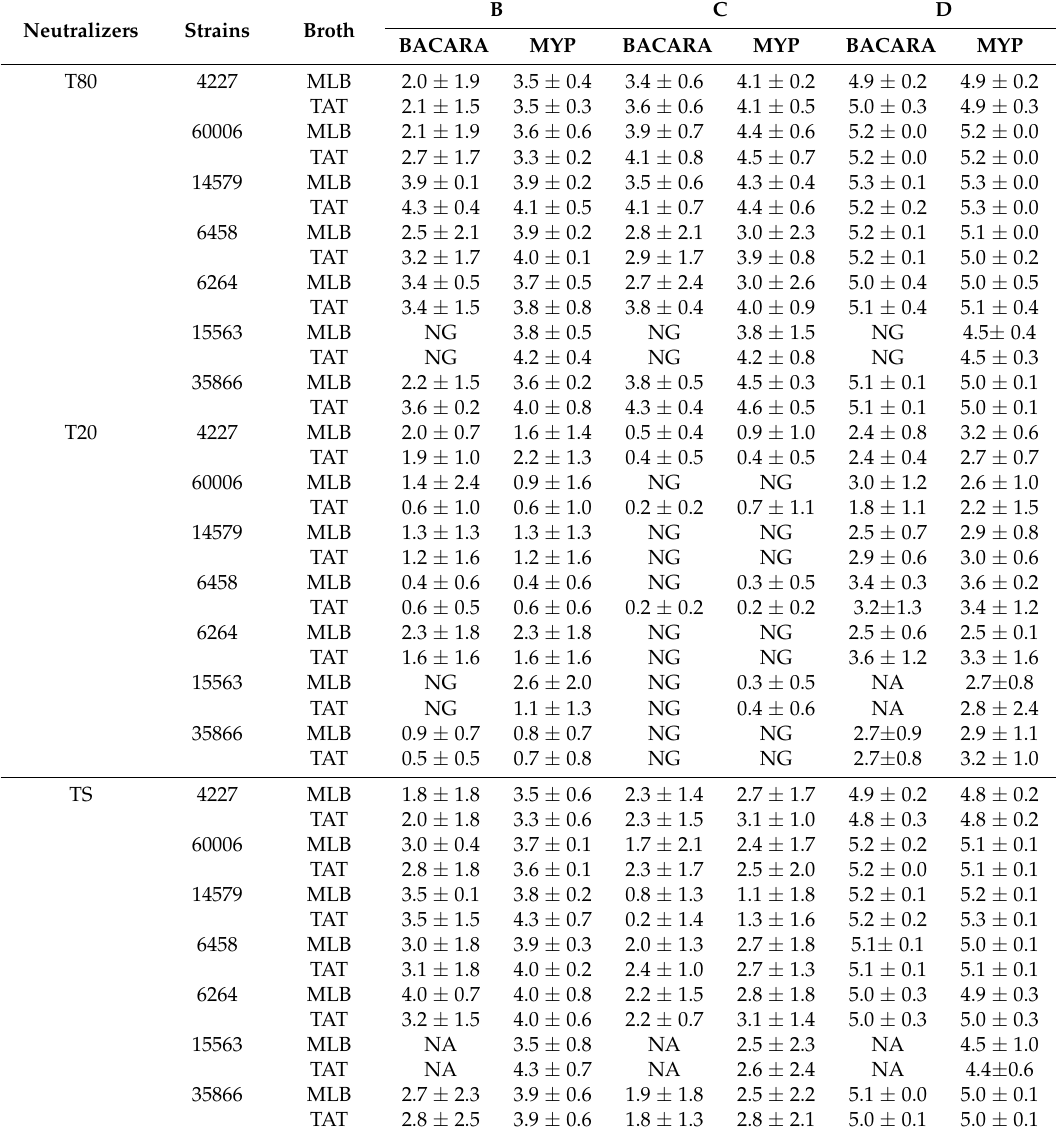
Table 5. Detection of Bacillus* strains in log CFU/g on BACARA and MYP after exposure to neutralized eye cream